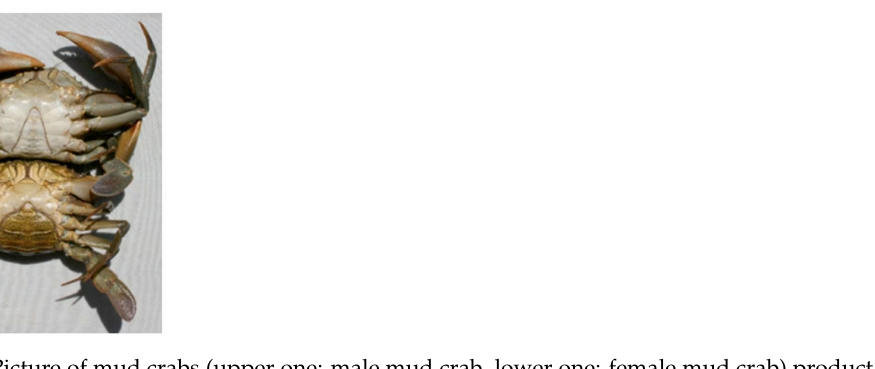
Figure 1. Picture of mud crabs (upper one: male mud crab, lower one: female mud crab) product subject to